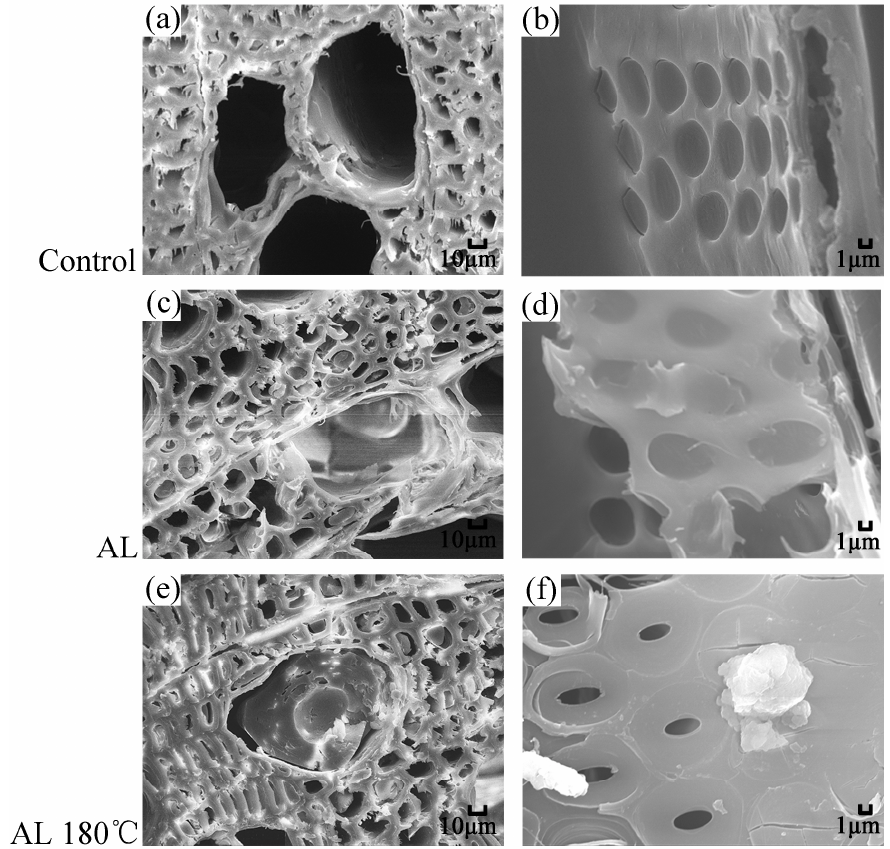
Figure 1. Scanning electron microscopy (SEM) images of ( a , c , e ) transverse-sections at magnification 500 and ( b , d , f ) tangential sections at magnification 3000 of the samples.